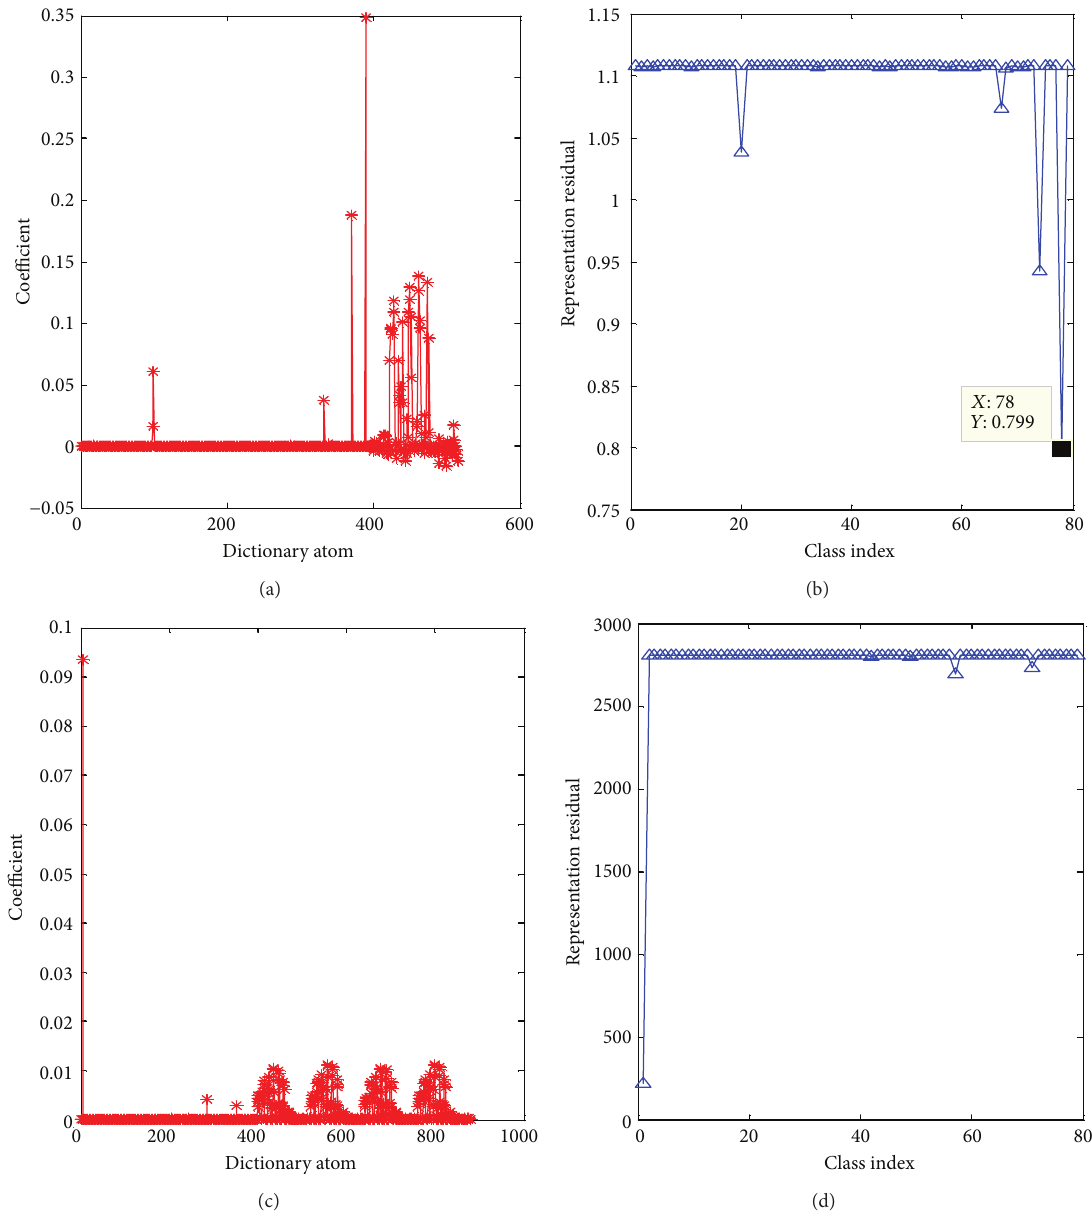
Figure 8: Sparse coding coefficients and representation residual of the 25% occluded test ear image from the first class of USTB; (a) and (c) plot the coding coefficients of Gabor orientation + SRC and Gabor orientation + NSRC. (b) and (d) illustrate the representation residual associated with each class by Gabor orientation + SRC and Gabor orientation + SRC,